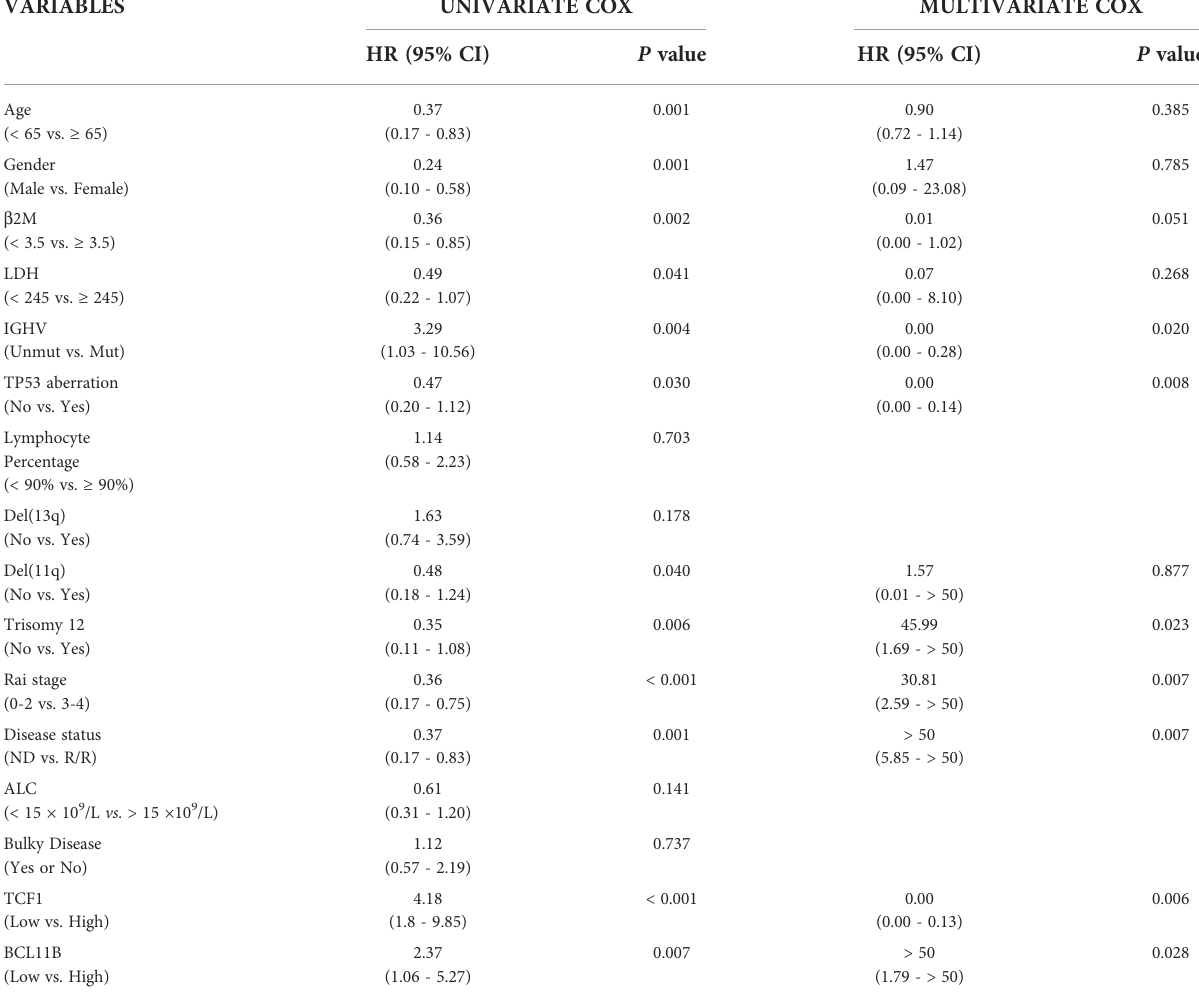
TABLE 1 Univariate and multivariate Cox regression analysis of risk factors associated with